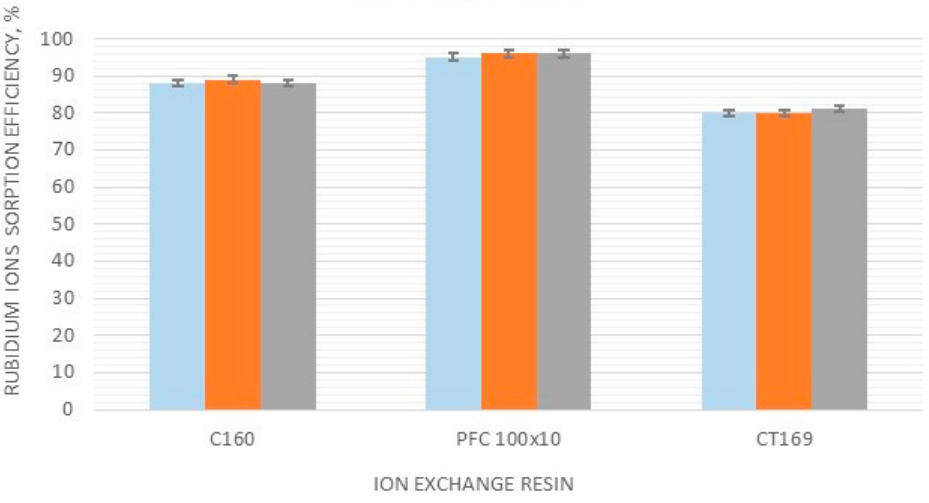
Figure 1 . Effect of temperature on the rubidium ion sorption efficiency. Figure 1. Effect of temperature on the rubidium ion sorption